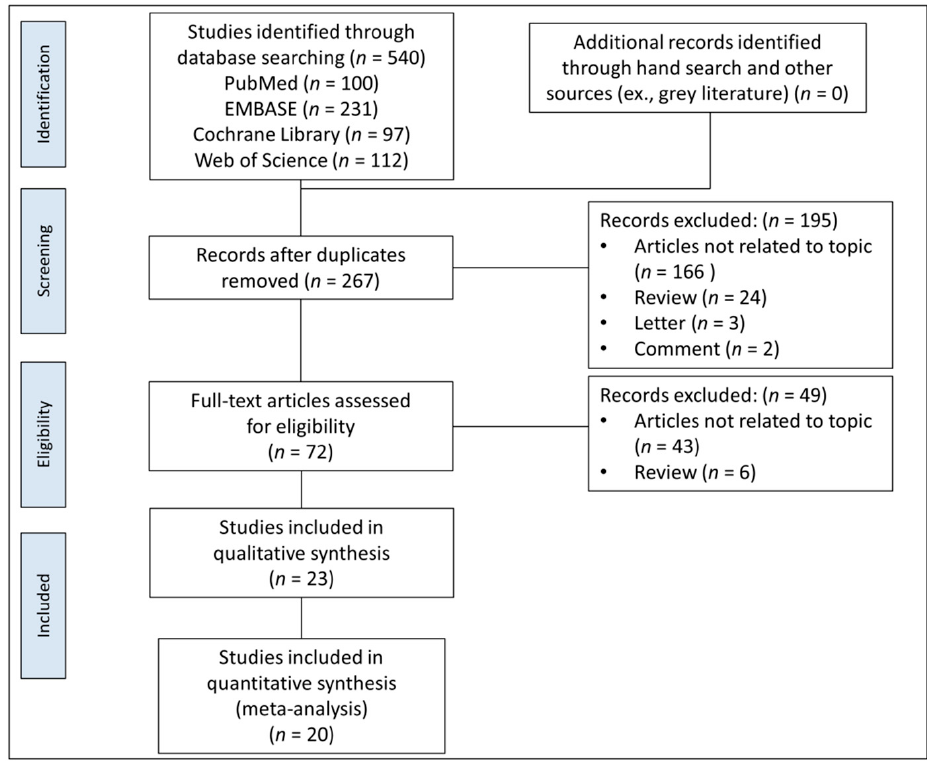
Figure 1. PRISMA flow diagram for identification of relevant studies.